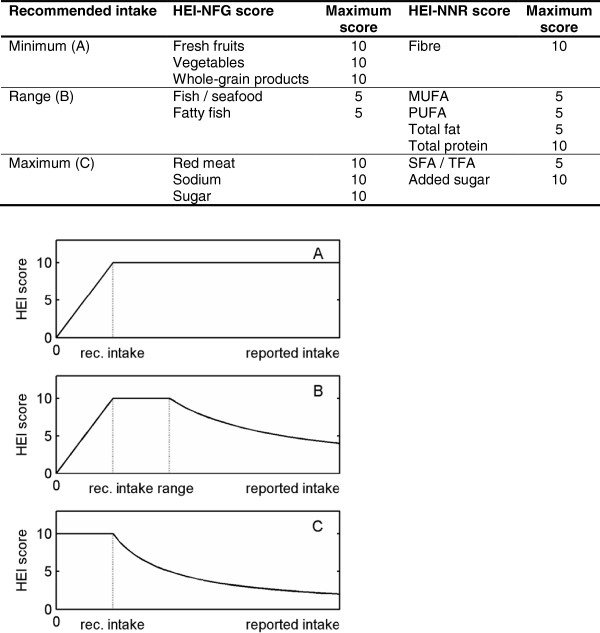
Illustration of scoring algorithms of the HEI-NFG and HEI-NNR. Abbreviations: HEI-NFG Healthy Eating Index based on Norwegian Food Guidelines, HEI-NNR Healthy Eating Index based on Nordic Nutrition Recommendations, rec recommended, MUFA Monounsaturated Fat, PUFA Polyunsaturated Fat, SFA/TFA Saturated Fat and Trans Fat.